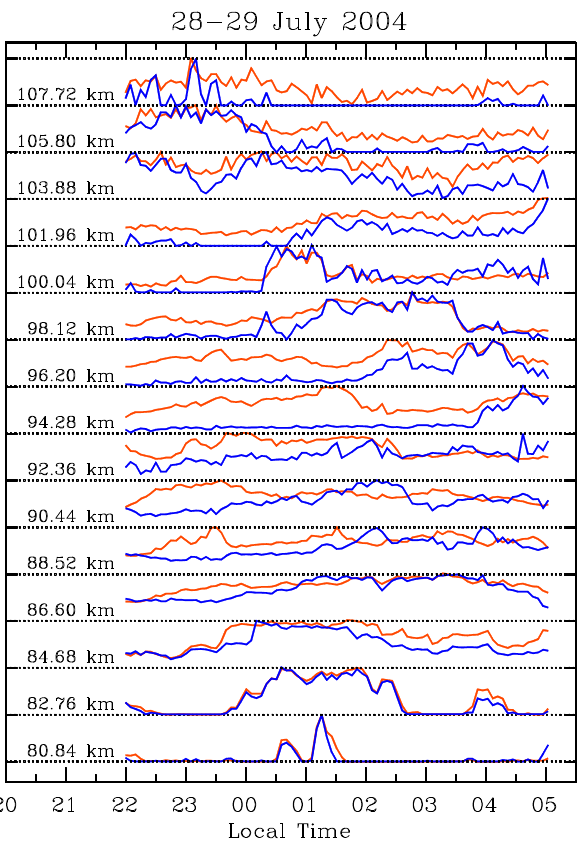
Fig. 6. Time variations of relative densities for Na (orange line) and Fe (blue line) observed at altitudes between 80.84 and 86.21km (plotted in every 4 altitude bins) during the night of 28–29 July 2004, which display altitude dependence of the Na and Fe time variation relations in detail. Note that the temporal variations of the Na and Fe relative densities show an excellent similarity on the bottommost layer underside, and difference occurs at higher altitudes.